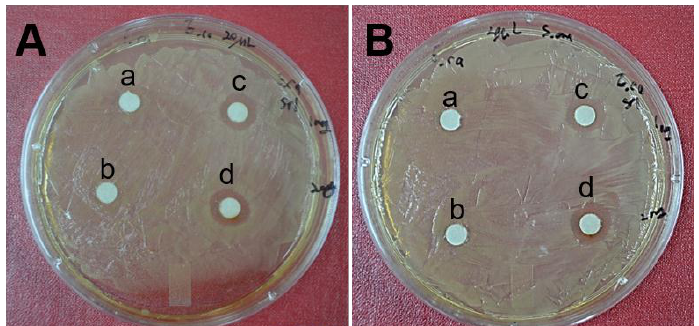
Figure 8. Antimicrobial activity of biosynthesized AgNPs, determined by an agar well diffusion assay. Pictures show inhibition zones produced by the biosynthesized AgNPs against E. coli and S. aureus. ( A ) E. coli colonies treated with: ( a ) 20 µg of aqueous extract of Ecklonia cava ; ( b ) 40 µg of aqueous extract of Ecklonia cava ; ( c ) 20 µg of AgNPs; and ( d ) 40 µg of AgNPs. ( B ) S. aureus colonies treated with: ( a ) 20 µg of aqueous extract of Ecklonia cava ; ( b ) 40 µg of aqueous extract of Ecklonia cava ; ( c ) 20 µg of AgNPs; and ( d ) 40 µg of AgNPs.